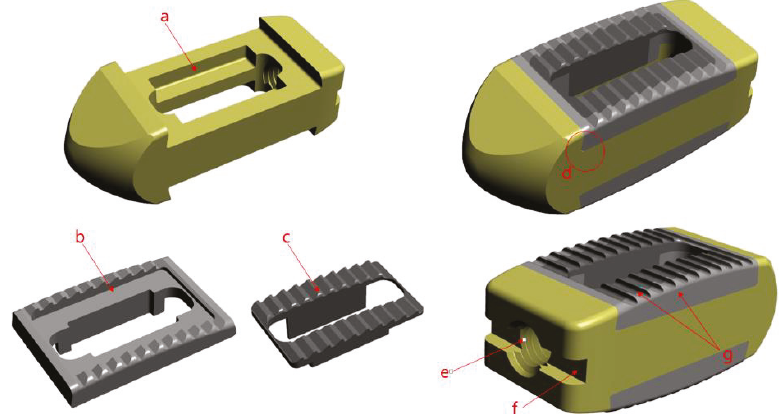
Figure 3. Design image ( a ) pocket shape, ( b ) solid structure, ( c ) porous structure, ( d ) dove-tail joint, ( e ) M3mm tap, ( f ) rectangular Pocket, ( g ) polishing machining.